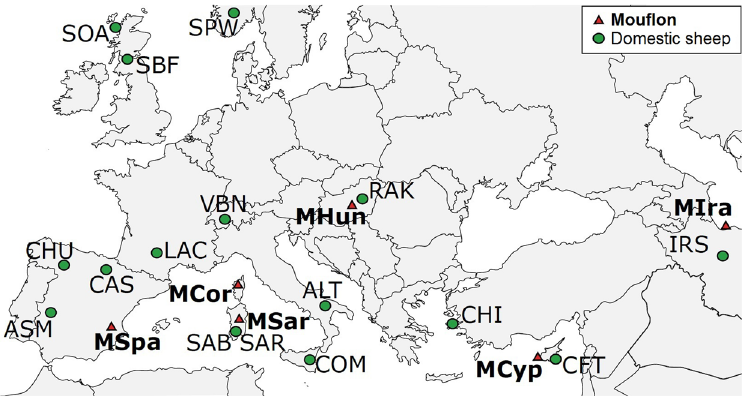
Figure 1. Sampling location. Geographic origin of mouflon and domestic sheep samples. For population abbreviations see Table 1. Map was generated in Inkscape v 0.91